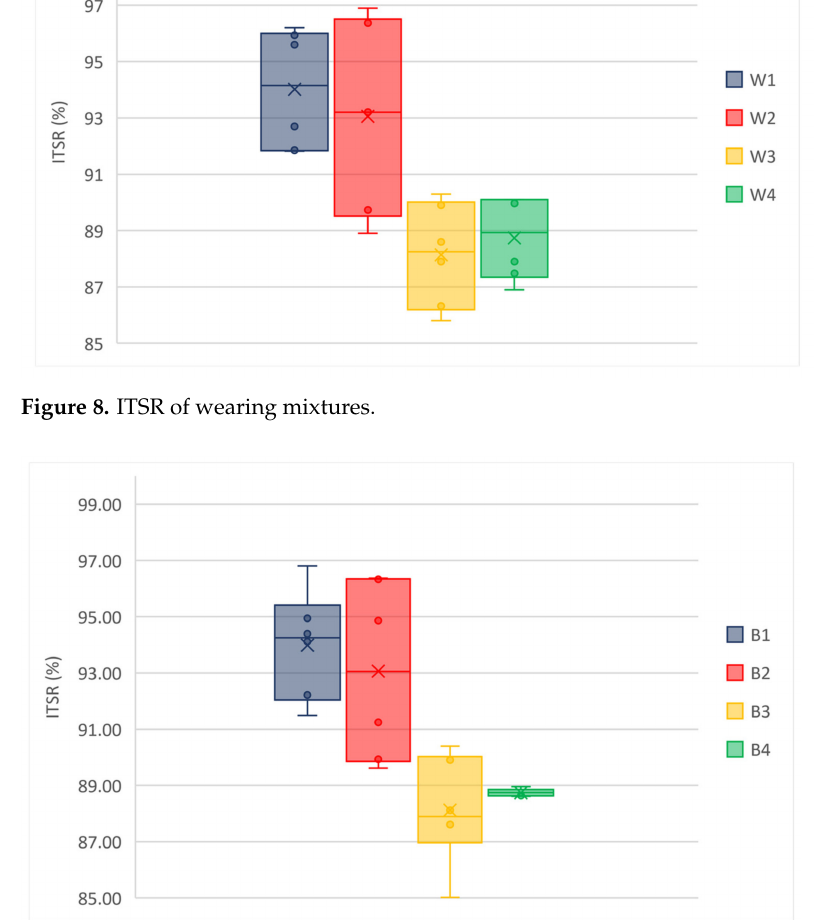
Figure 9. ITSR of binder